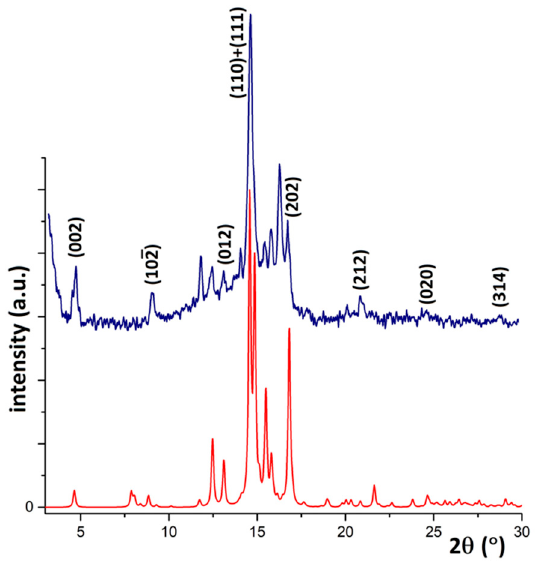
Figure 11. Top (blue pattern): experimental p-XRD pattern for compound 10a , after baseline correction, with indexation of main planes. Bottom (red pattern): simulated p-XRD pattern for 10a [55] based on the single-crystal structure (Figure 6), assuming the presence of preferred orientation. Main simulation parameters are λ = 1.54056 Å, r = 1.8, FWHM = 0.15° (2 θ scale), and preferred orientation = axis c.